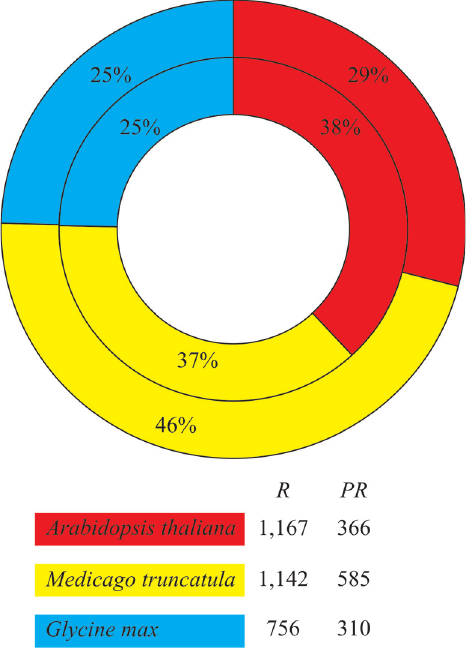
Figure 1 - R and PR genes encountered in soybean, Arabidopsis and Medicago transcriptomes. R genes are represented in the outer circle and PR genes in the inner circle for each